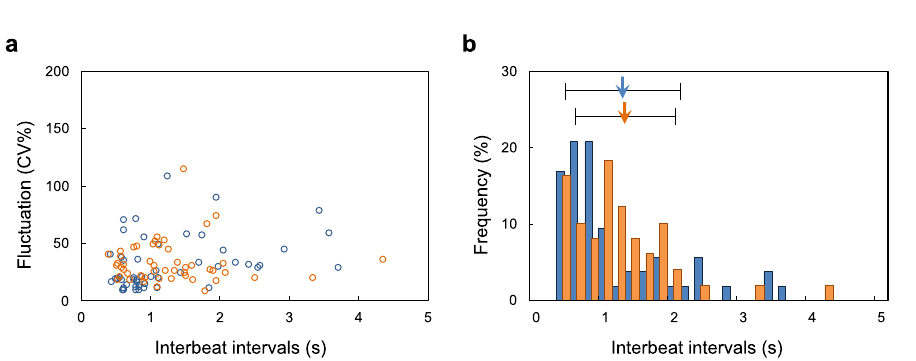
Figure 5. Influence of trypsinization on interbeat intervals in dispersed individual hES cardiomyocytes. ( a ) Distribution of the IBIs and the CV of IBIs in single hES cardiomyocytes before and after trypsinization. The blue open circles indicate the single hES cardiomyocytes (n = 50) before trypsinization. The orange open circles indicate the single cardiomyocytes (n = 50) after trypsinization. ( b ) Histograms of IBIs of hES single cardiomyocytes before and after trypsinization. The blue filled bars indicate the mean IBIs of single cardiomyocytes before trypsinization; the blue arrow and error bar indicate their mean value and SD. The orange filled bars indicate the frequency of mean IBIs of trypsinized single cardiomyocytes; the orange arrow and error bar indicate their mean value and